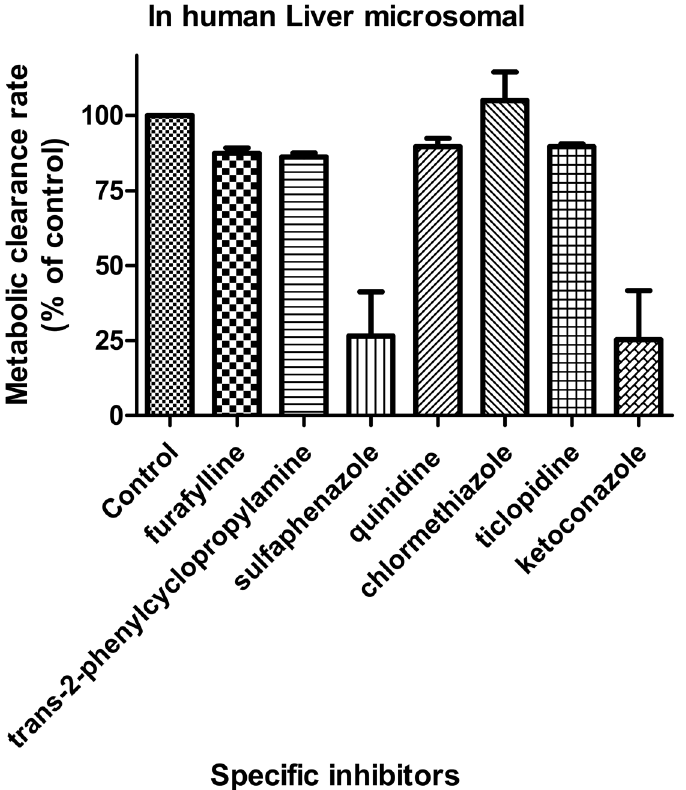
Fig 3. Effect of specific inhibitors on CYP-mediated CK (50 μ M) metabolism in HLMs. Note: Furafylline, tranylcypromine, sulfaphenazole, quinidine, chlormethiazole, ticlopidine, and ketoconazole were used as the specific inhibitors for CYP1A2, CYP2A6, CYP2C9, CYP2D6, CYP2E1, and CYP2C19, respectively. The incubation conditions are described in the materials and methods section. Each data point represents the average of triple determinations and error bars. In the presence of sulfaphenazole (1 μ M) and ketoconazole (1 μ M), the metabolic clearance rate of CK decreased to 73.5% and 74.6% of that of the control, respectively, whereas the other inhibitors had no significant inhibitory effects on the metabolism of